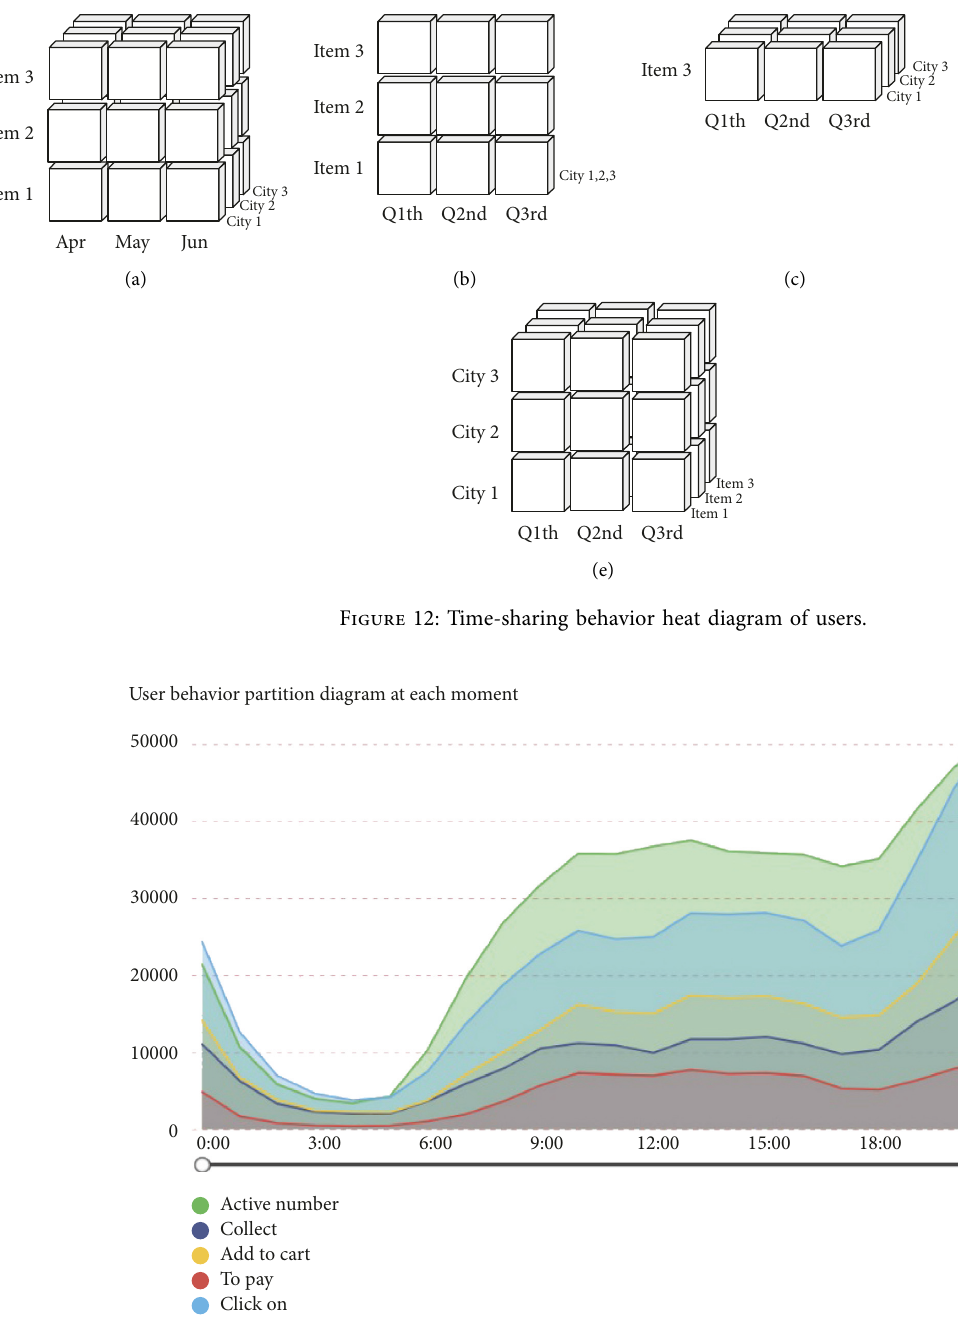
Figure 13: Multidimensional analysis operation of